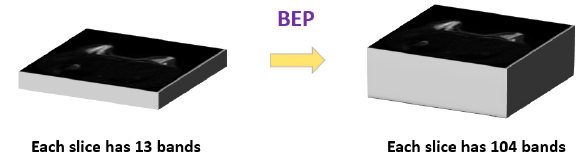
Figure 5. Band expansion process (BEP).